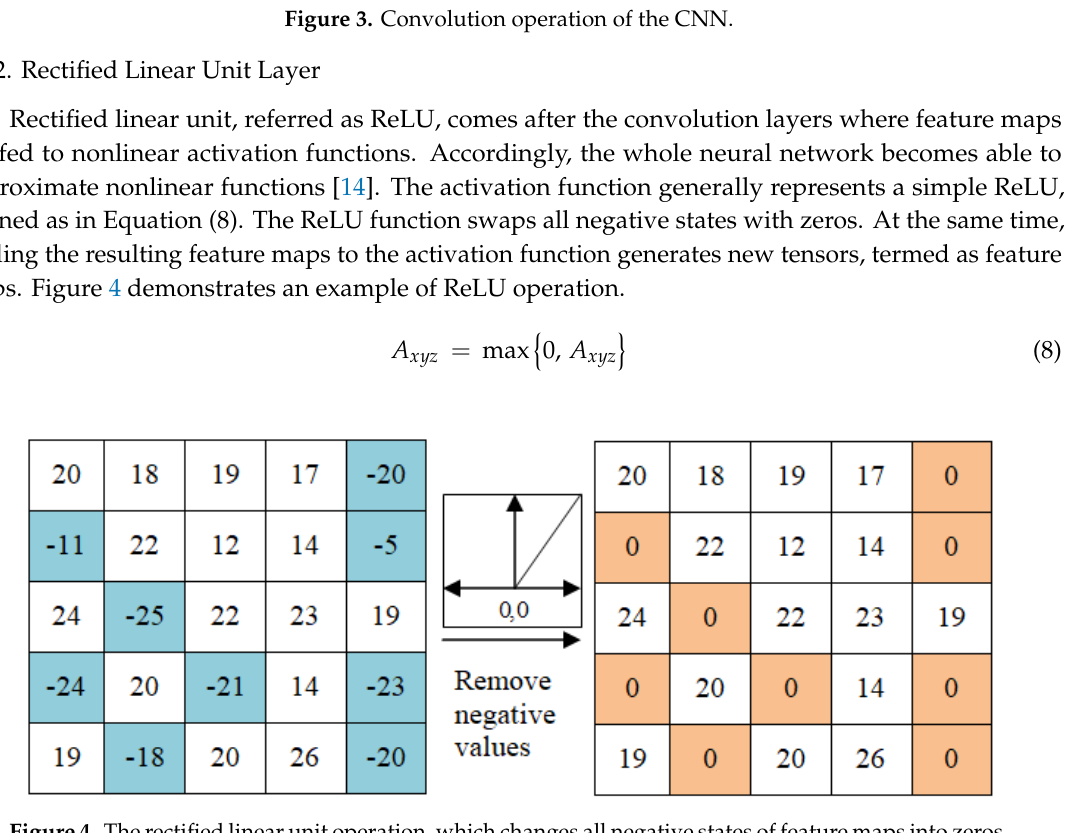
Figure 4. The rectified linear unit operation, which changes all negative states of feature maps into zeros.